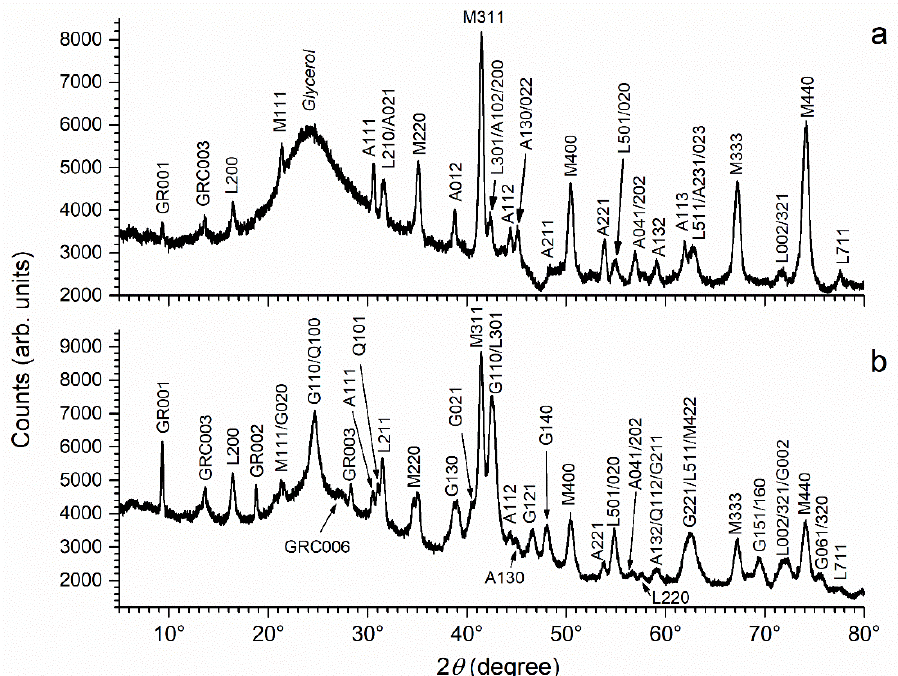
Figure 2. XRD pattern of the corrosion product layers formed after 6 months in: ( a ) artificial and ( b ) natural seawater. GR = GR(SO 42 − ), GRC = GR(CO 32 − ), A = aragonite, G = goethite, L = lepidocrocite, M = magnetite and Q = quartz, with the corresponding Miller index.